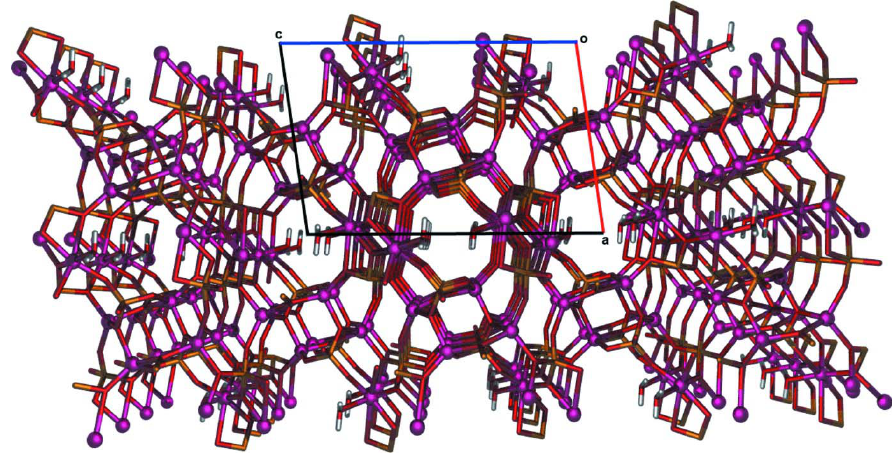
Figure 2 A schematic representation of a section of the three-dimensional network of (I) in a projection along [010]. Hydrogen atoms are omitted for